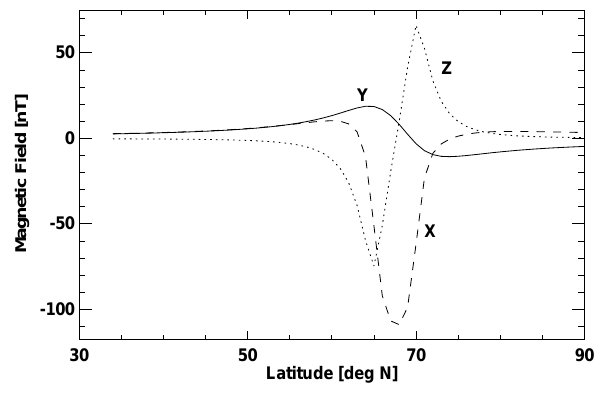
Fig. 6. Model latitude profile across the midnight sector auroral oval after substorm expansive phase. This is precisely the type of profile seen shortly after EP onset (cf. Bonnevier et al., 1970; Kisabeth and Rostoker, 1974).